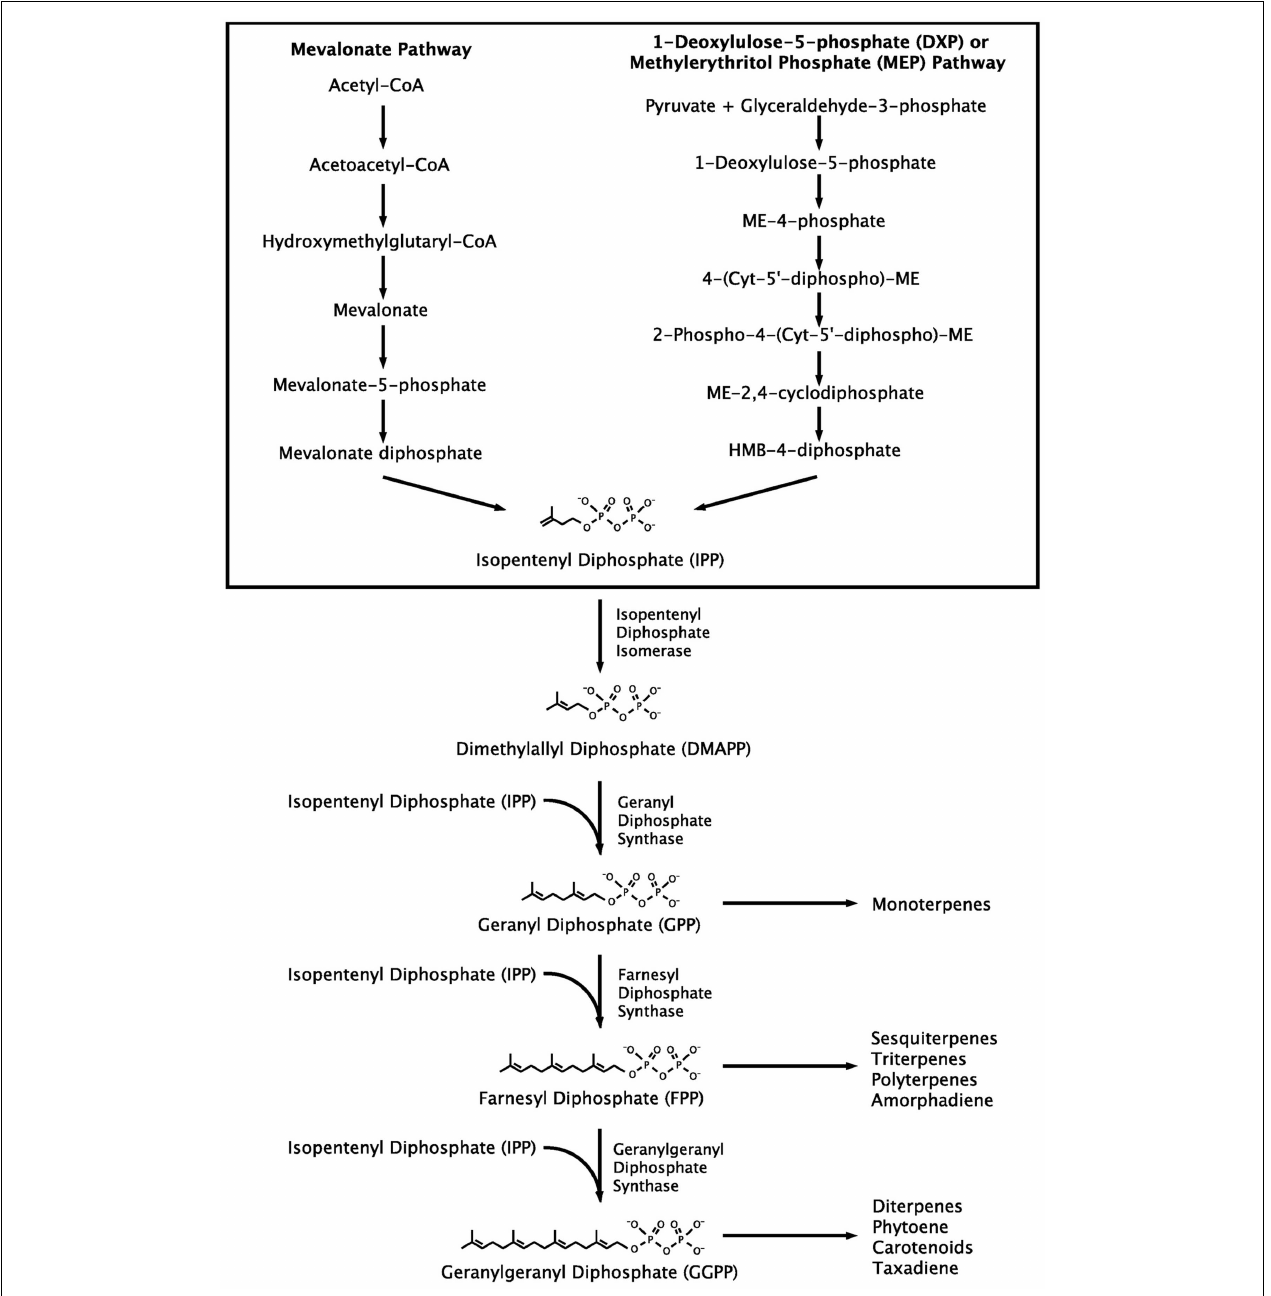
FIGURE 1 | Isoprenoid pathway. Two distinct pathways for IPP production are shown together, but they exist in different organisms.